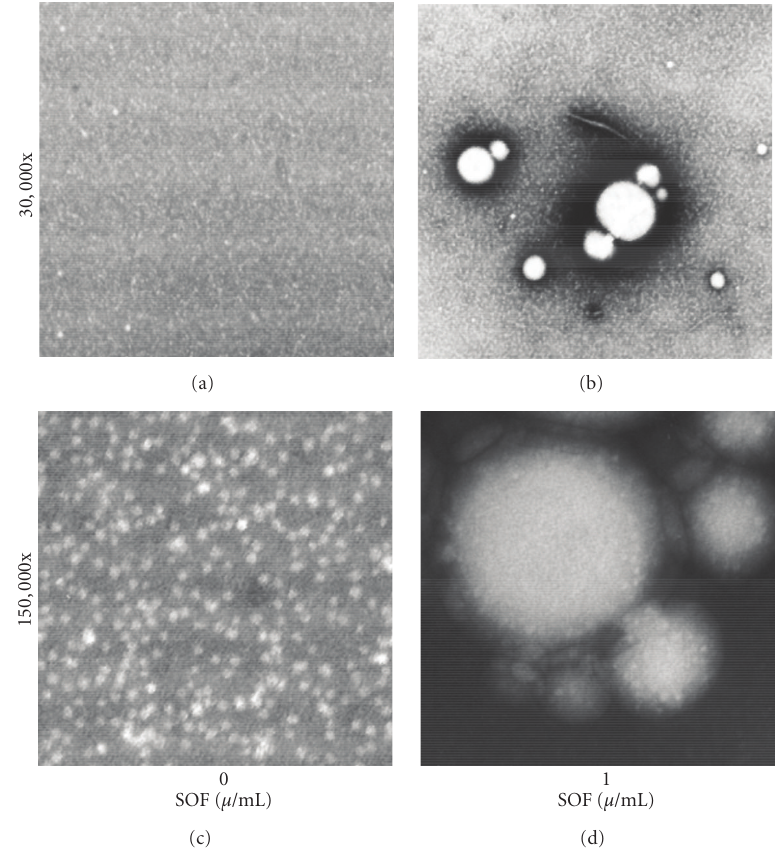
Figure 6: Electron micrographs of HDL treated with SOF. Indicated concentrations of rSOF were incubated with human HDL overnight at 37 ◦ C, stained with 2% phosphotungstic acid, and electron micrographs taken at the indicated